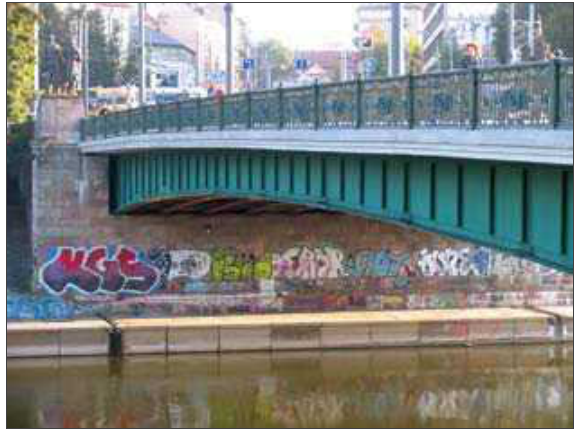
4 pav. Šiuolaikinė spontaniškoji miestų grafika Fig. 4. Graffiti in contemporary